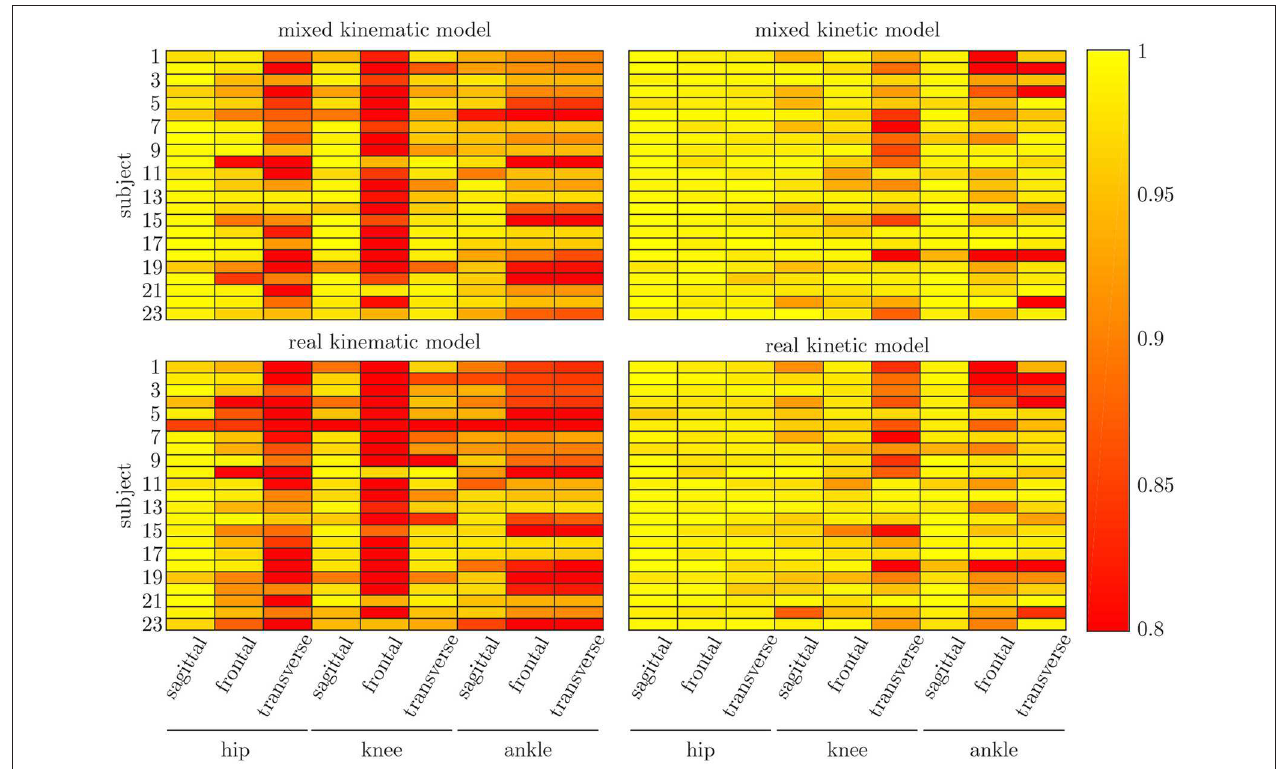
FIGURE 8 | Mean correlation coefficient for each joint and motion plane of each subject in the test set. On top, the results for the combined input data are displayed, while on bottom, the results of the model using measured data only are depicted. There are only small differences between both models, while there are distinct differences in the different motion planes and between